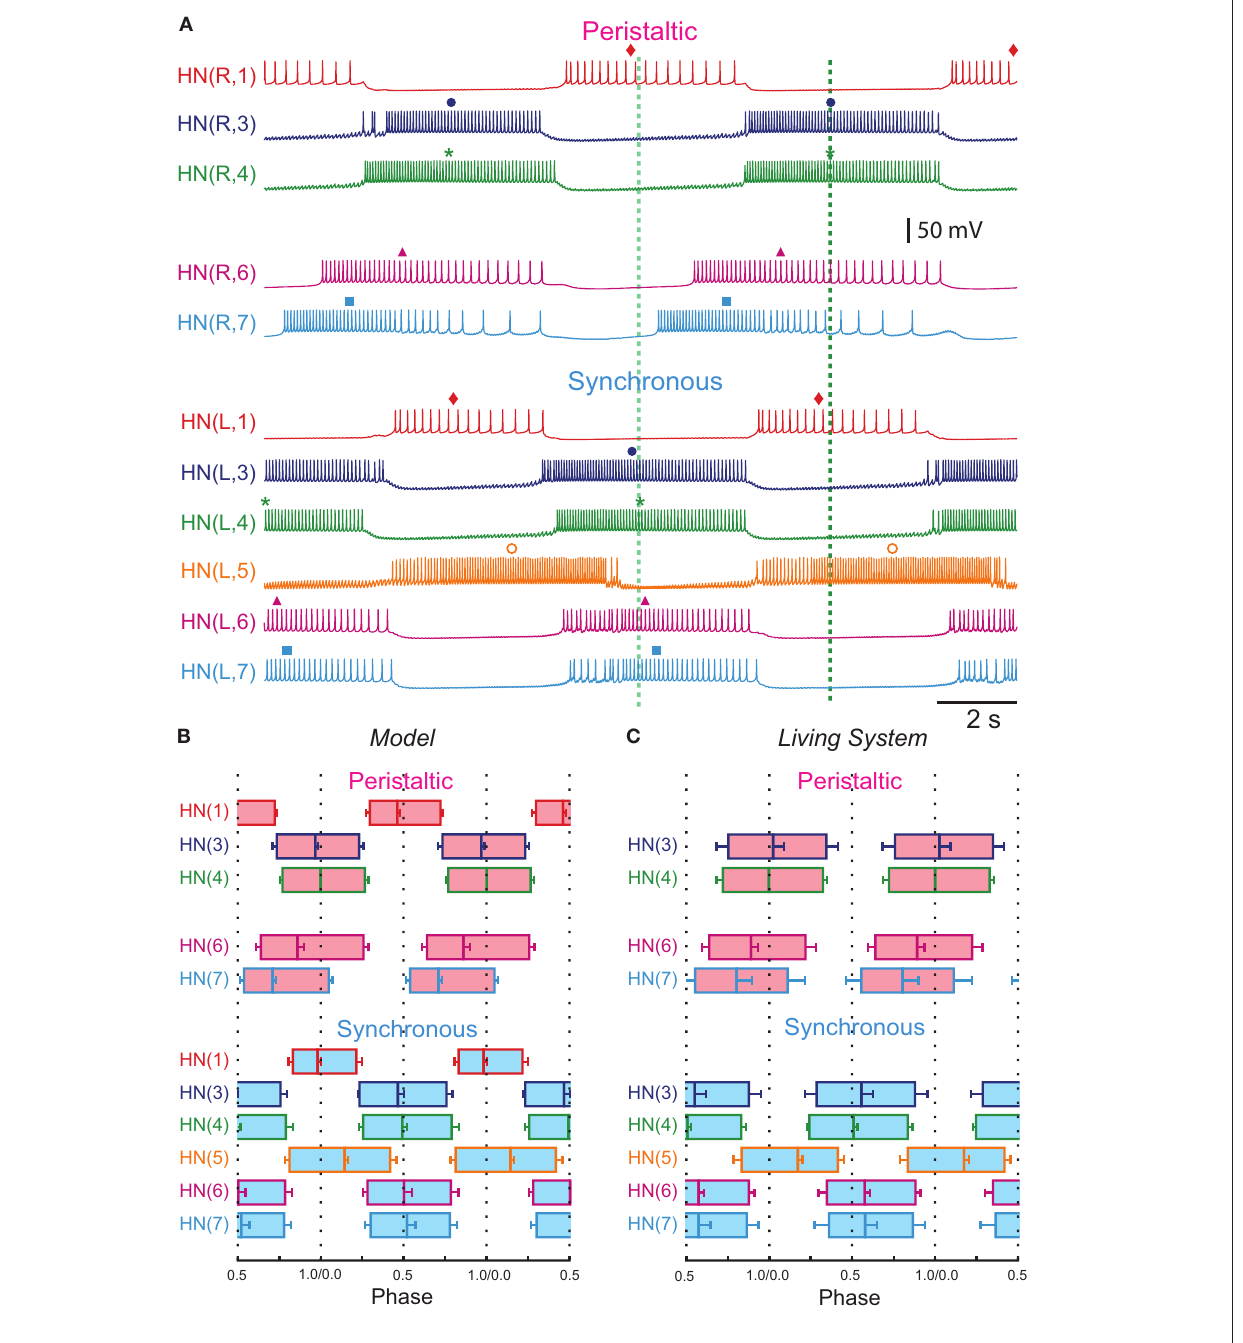
model activity based on data from (A) . (C) Phase diagram of living system activity from Norris et al. (2006). The phase diagrams give average first spike phase (left edge of each box), middle spike phase (middle line in each box – simply referred in the text as phase) and last spike phase (right edge of each box) all with SD (horizontal “error” bars). Box fill color shows coordination mode, synchronous (light blue) and peristaltic (pink) and box boundary colors [red HN(1,2), blue HN(3), green HN(4), orange HN(5), magenta HN(6), turquoise HN(7)] indicate the interneuron and correspond to trace colors in (A)